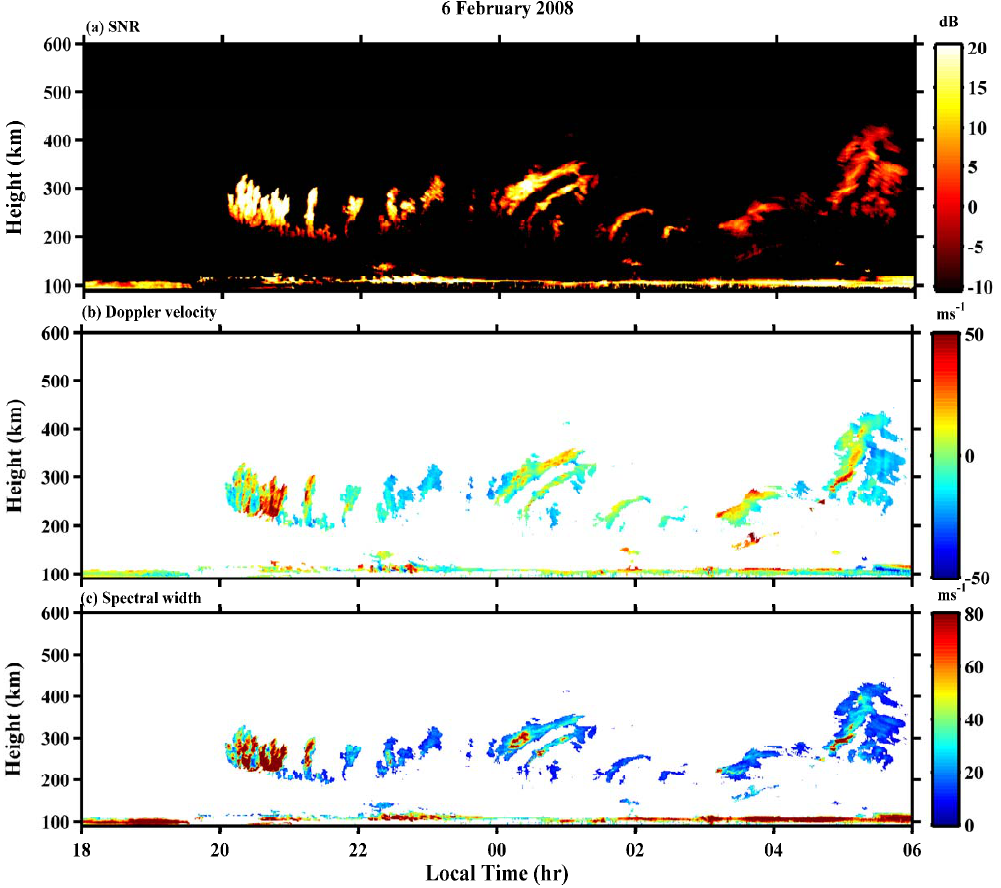
Fig. 1. Height-time variation of (a) SNR, (b) radial Doppler velocity, and (c) spectral width of the E- and F-region echoes observed on 6 February 2008. Positive (negative) velocity represents line-of-sight irregularity motion away from (towards) the